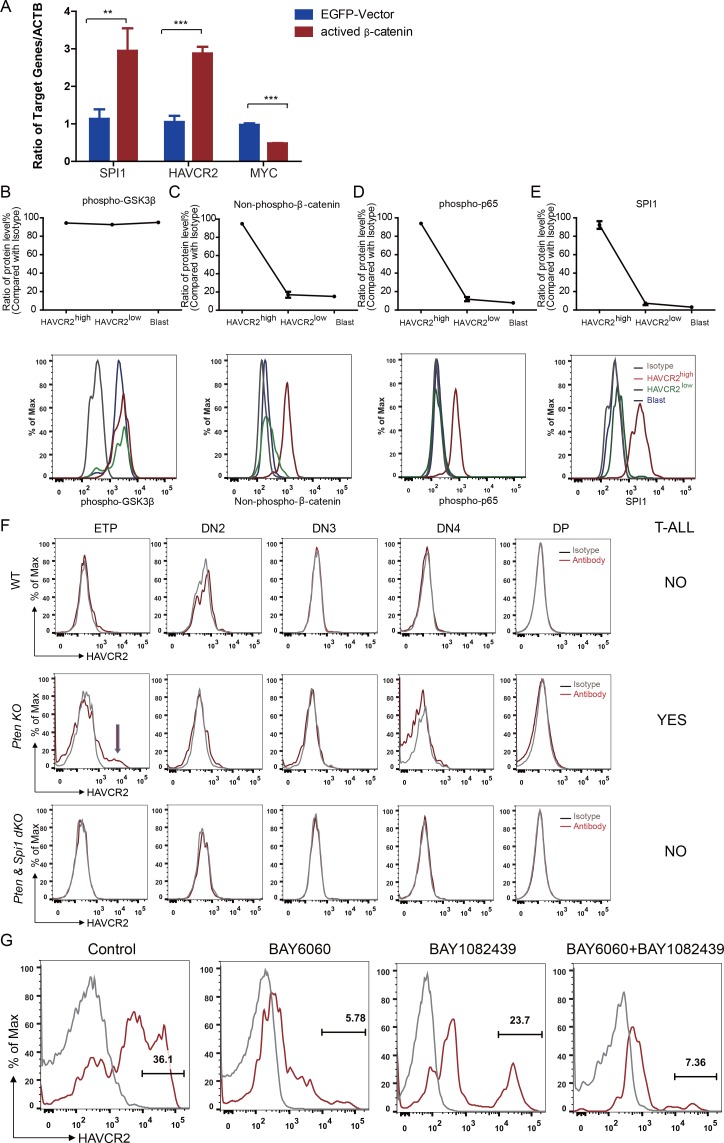
Spi1 expression is maintained by β-catenin-SPI1-HAVCR2 regulatory circuit.(A) q-PCR analysis of SPI1 and SPI1-regulated HAVCR2 and c-MYC expressions after the overexpression of active β-catenin in the Jurkat T-ALL cell line (red bars). The data are normalized to that of empty plasmid controls (blue bars); (B–E) Upper panels: quantitative intracellular FACS analyses of P-GSK-3β, non-phospho-β-catenin, P-p65 and SPI1 levels in the HAVCR2high, HAVCR2low and blast subgroups; lower panels: representative intracellular FACS analysis of P-GSK-3β, non-phospho-β-catenin, P-p65 and SPI1 levels in the HAVCR2high, HAVCR2low and blast subgroups. Gray line, isotype control;(F) FACS analysis shows cells in the HAVCR2high subgroup at the ETP/DN1 stage, which are absent in WT and dKO mice; (G) Representative FACS plots show the number of cells in the HAVCR2high subgroup in the different drug treatment groups. The data in A, B, C, D and E are the means ± S.Ds of 3 independent tests; *p≤0.05; **p≤0.01; ***p≤0.001.